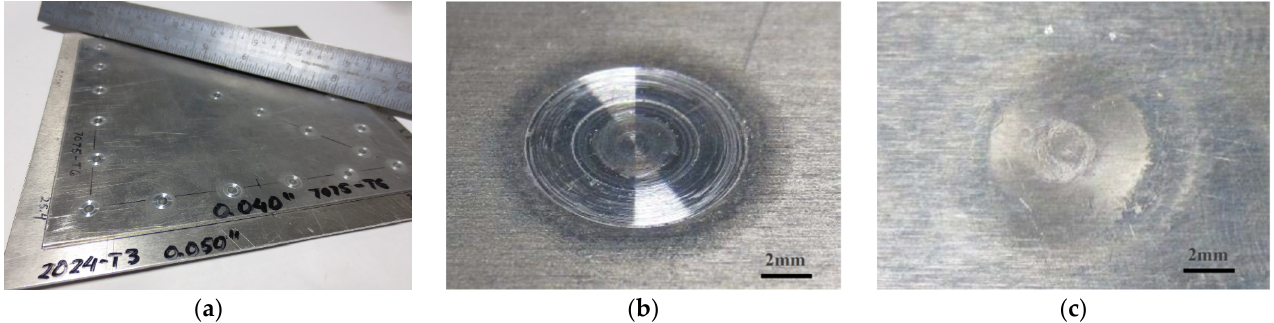
Figure 2. Refill friction stir spot welds: ( a ) a sample with refill spot welds, ( b ) top view of a refill spot weld, and ( c ) bottom view of a refill spot weld. All images depict perspective views.